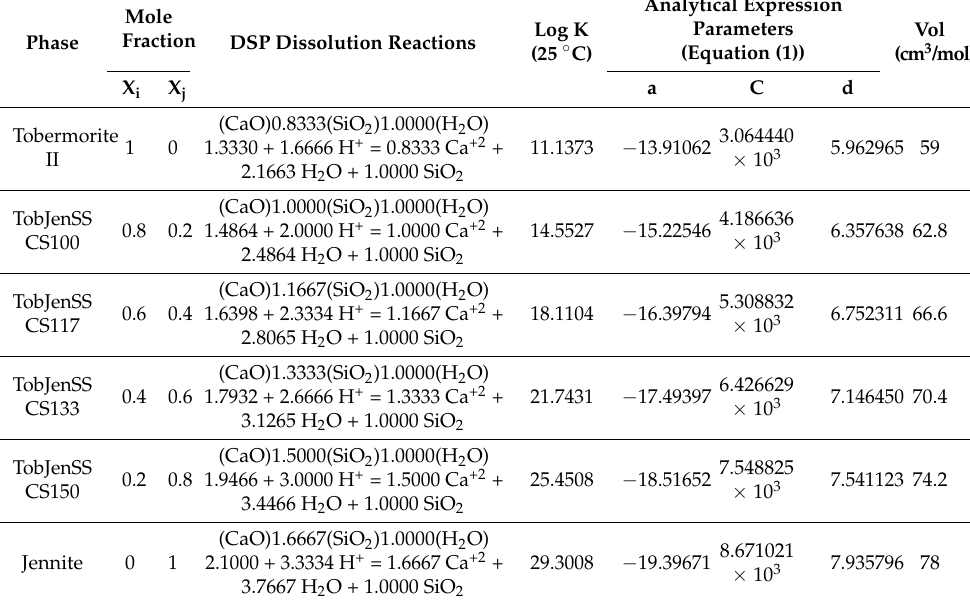
Table 2. End-members and DSP for the CSH